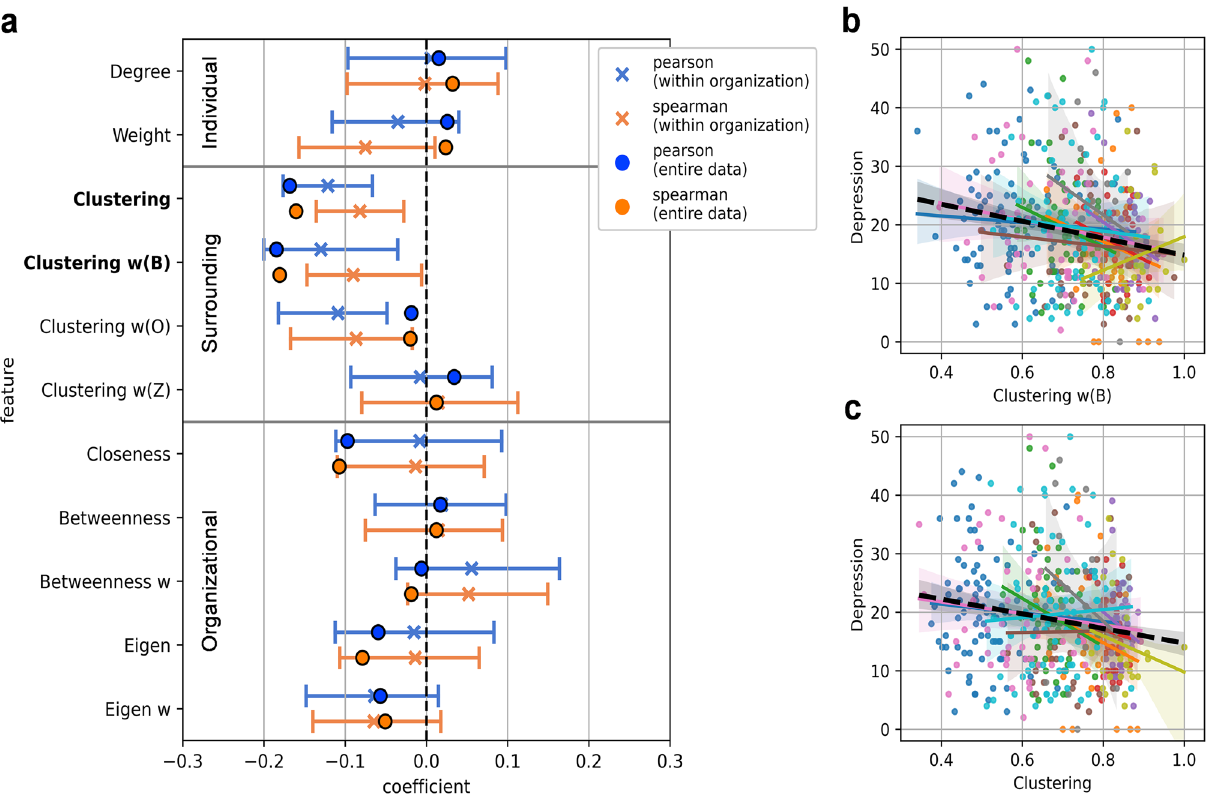
Figure 2. Correlation between social network characteristics and depression score. ( a ) The circle-marker indicates correlation coefficients for the entire dataset (N = 449). The x-marker and error bar indicate the mean and 95% confidence interval of correlation coefficients within each organization (N = 10) calculated by 1000 bootstrap samples. Features in bold type have significant correlations in both Pearson and Spearman correlations in the entire dataset ( p < 0.05; two-tailed p value adjusted by Benjamini–Hochberg method). ( b ), ( c ), Each scatter plot shows the relationship between Clustering w(B) , Clustering , and depression score. The black dashed line indicates the linear regression of the entire dataset, and each coloured solid line indicates the linear regression within a single